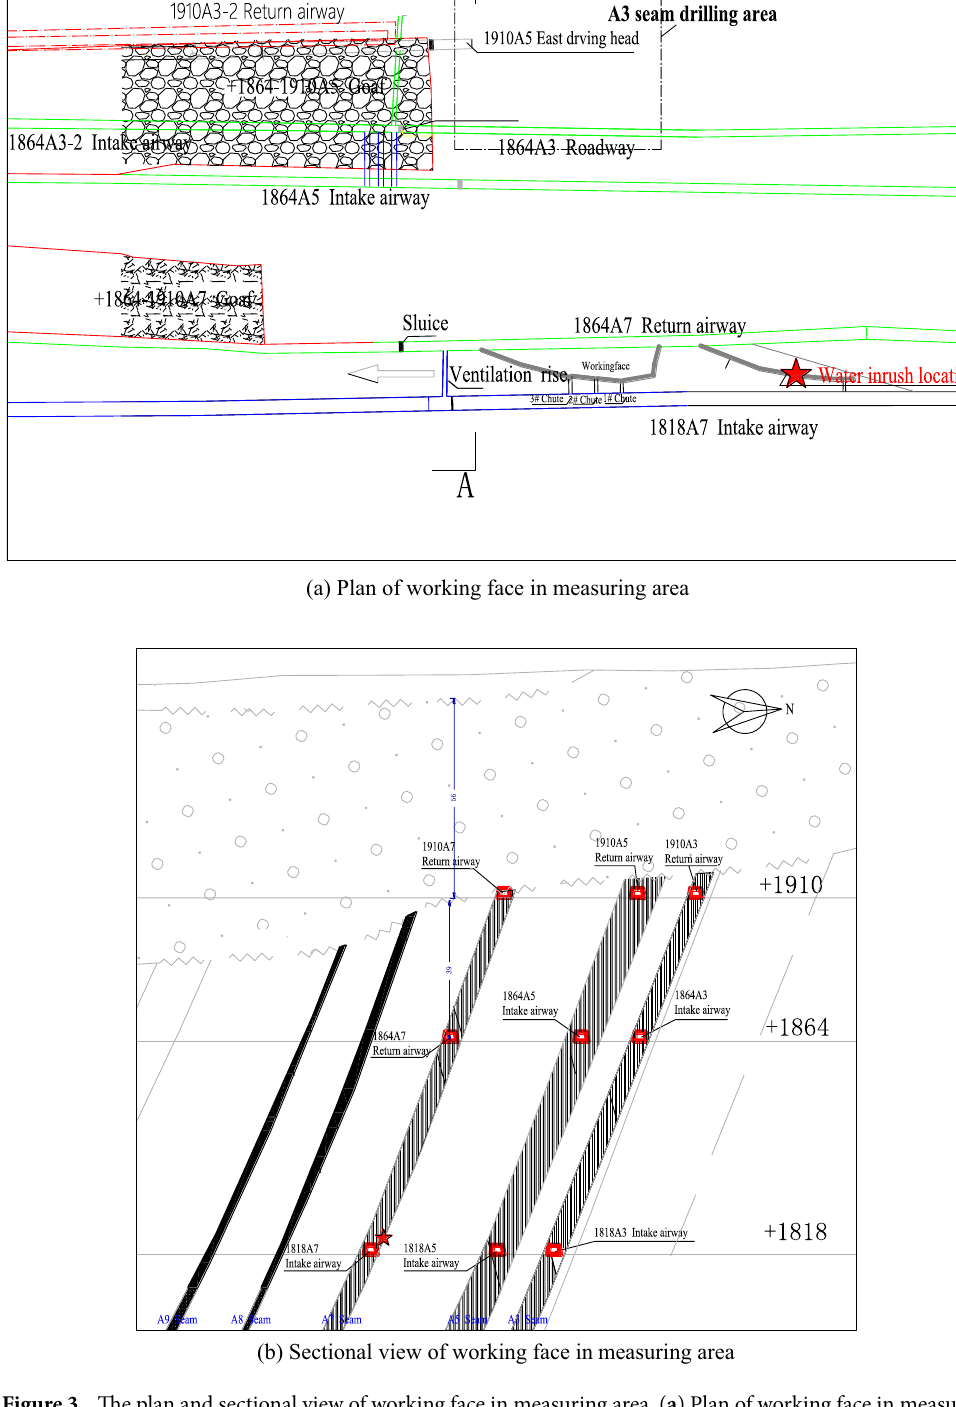
Figure 3. The plan and sectional view of working face in measuring area. ( a ) Plan of working face in measuring area, ( b ) Sectional view of working face in measuring